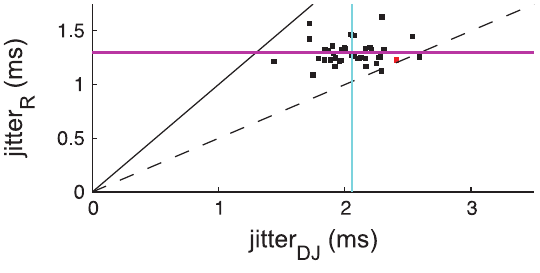
such as entropy and mutual information in our data and models.